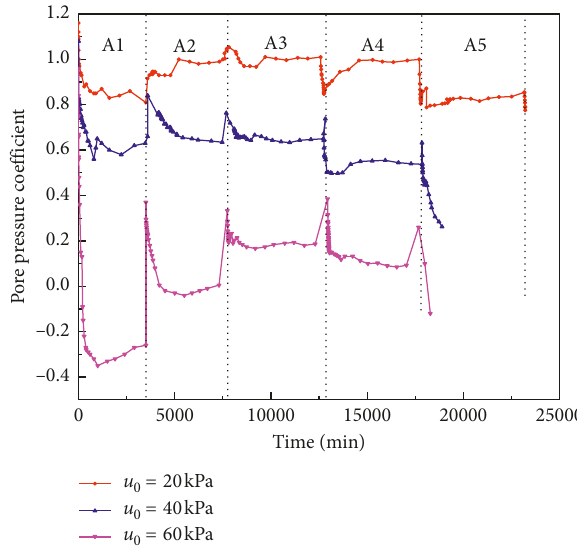
Figure 6: The relationship between pore water pressure coefficient and